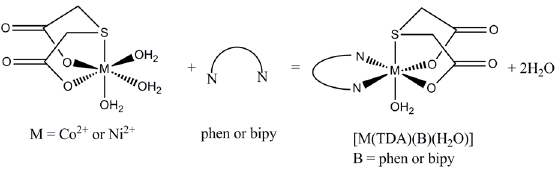
Scheme 1 : The substitution reaction of the binary complexes with the phen or bipy ligand.